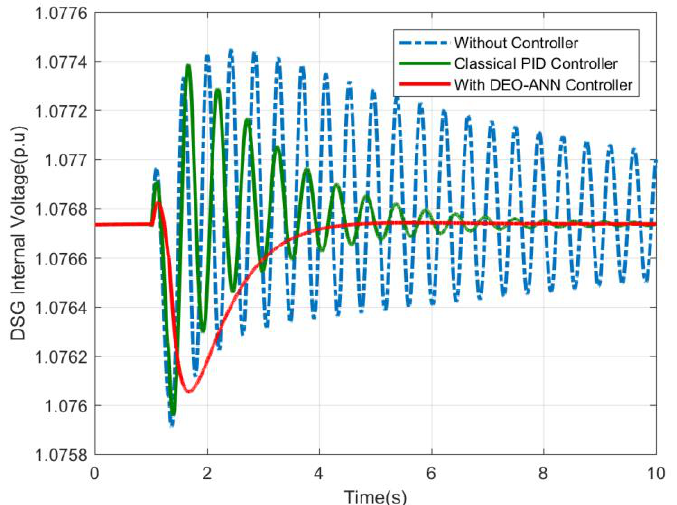
Figure 14. Diesel synchronous generator (DSG) internal voltage.